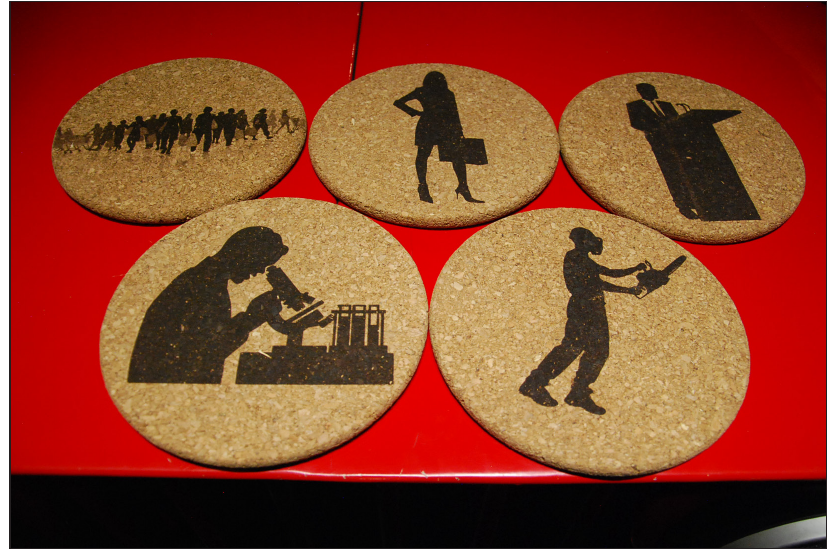
Figure 3: Coasters used when discussing the responsibility of the palm oil use. Universeum 2017. (Photo: Lars